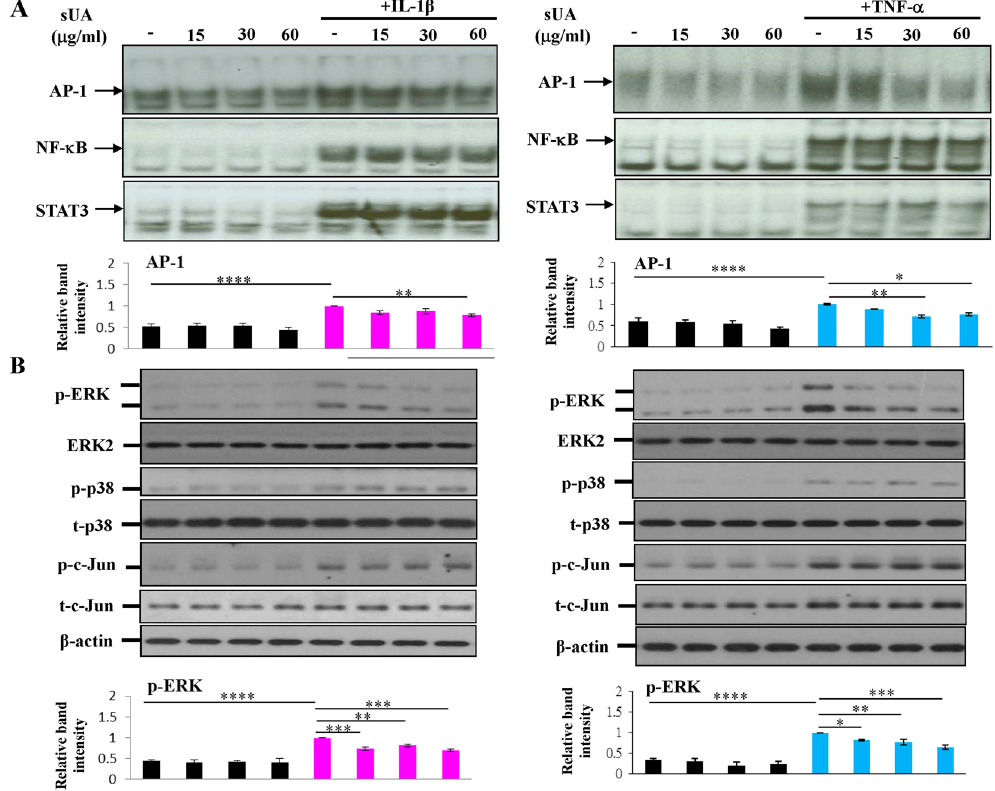
Figure 3. Suppression of TNF- α - and IL-1 β -induced ERK-AP-1 signalling by sUA. Chondrocytes (3 × 10 6 for each condition) were pretreated with or without various concentrations of sUA for 72 h and then stimulated with IL-1 β or TNF- α for another 8 h. The cells were collected, and the nuclear extracts were prepared for the determination of AP-1, NF- κ B, and STAT3 DNA-binding activity by EMSA analysis ( A ). In ( B ), the chondrocytes were pretreated with various concentrations of sUA for 72 h and then stimulated with IL-1 β or TNF- α for 2 h. Phosphorylated ERK, phosphorylated p38, and phosphorylated c-Jun expression levels were determined by western blotting. The cropped blots are displayed and full-length blots are shown in the Supplementary Figure 8. The results from at least 3 independent experiments are shown. * p < 0.05; ** p < 0.01; *** p < 0.001; **** p <